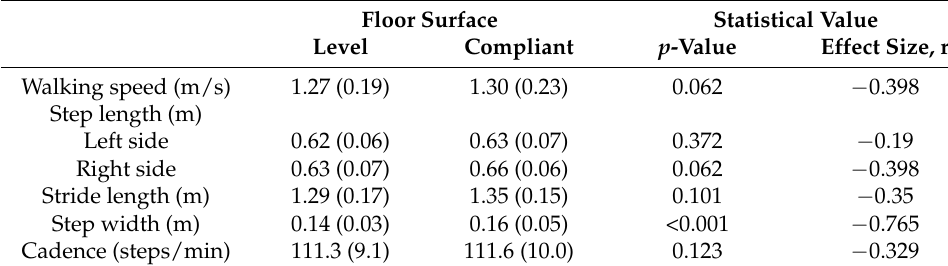
Table 2. A comparison of spatiotemporal gait parameters on different walking surfaces.